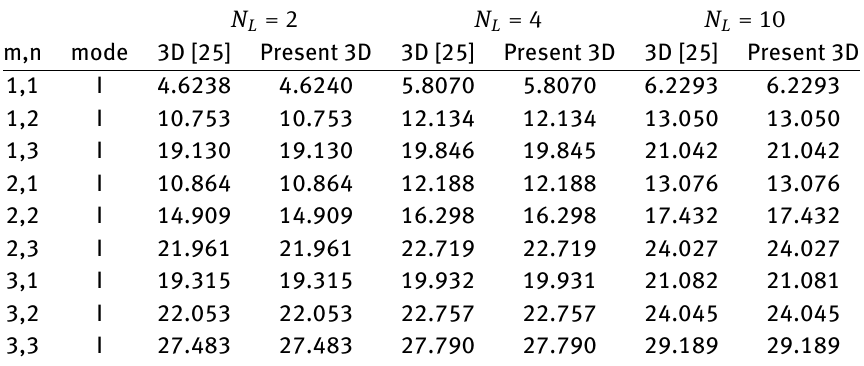
Table 4: Fourth assessment for the 3D exact solution, simply supported composite spherical panel with thickness ratio R α / h = 50 . Circular √︁ ρ frequencies ¯ ω = ωR α for several physical layers N L , lamination sequence ( 0 ∘ /90 ∘ /0 ∘ /90 ∘ / . . . ) and half-wave numbers m and E 0